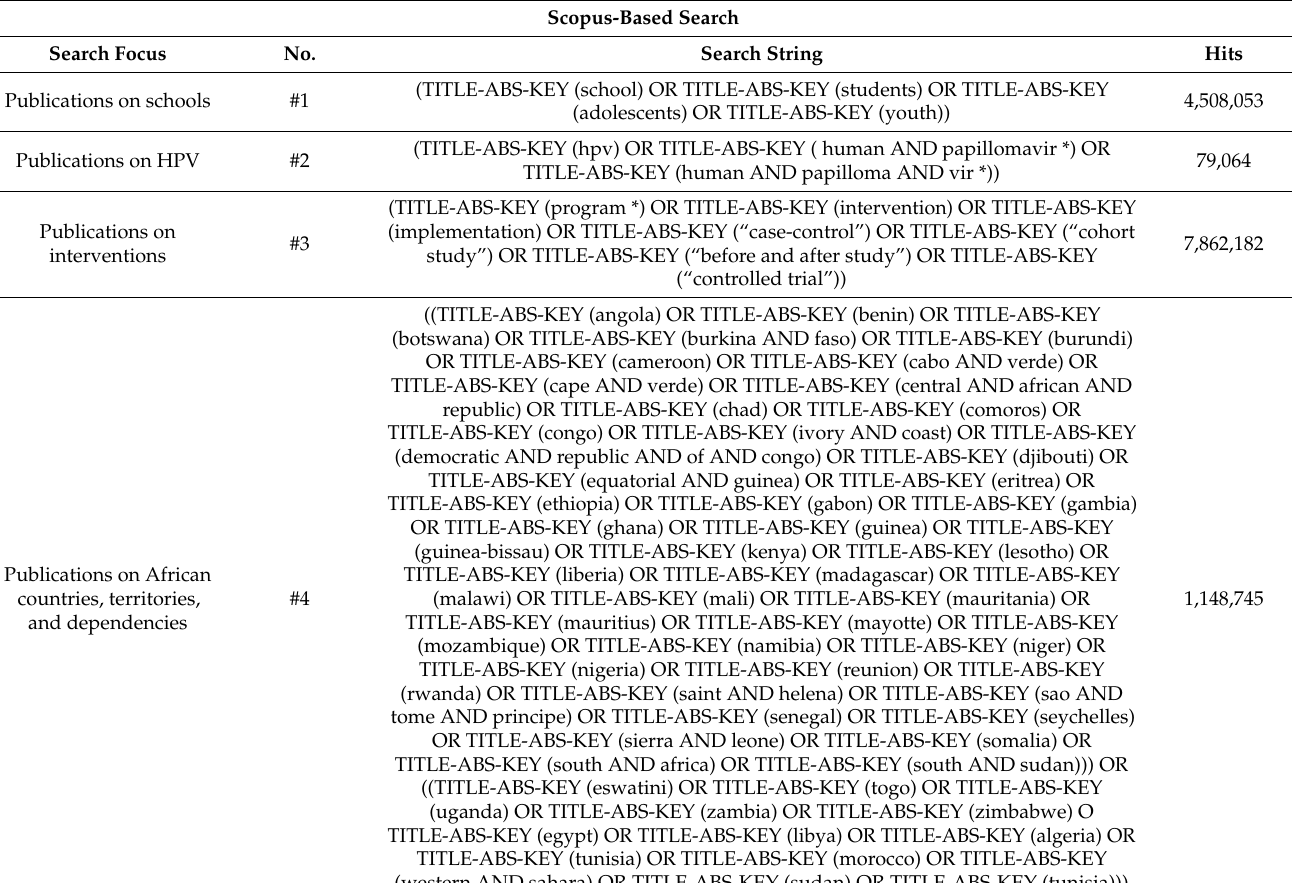
Table A1. Search